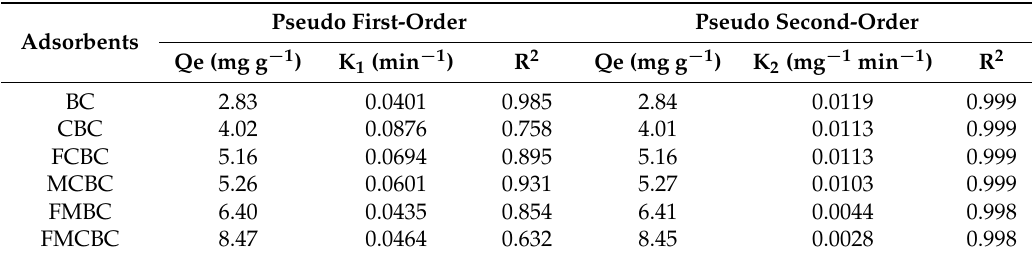
Table 3. The parameters of dynamic fit of BC and modified materials.